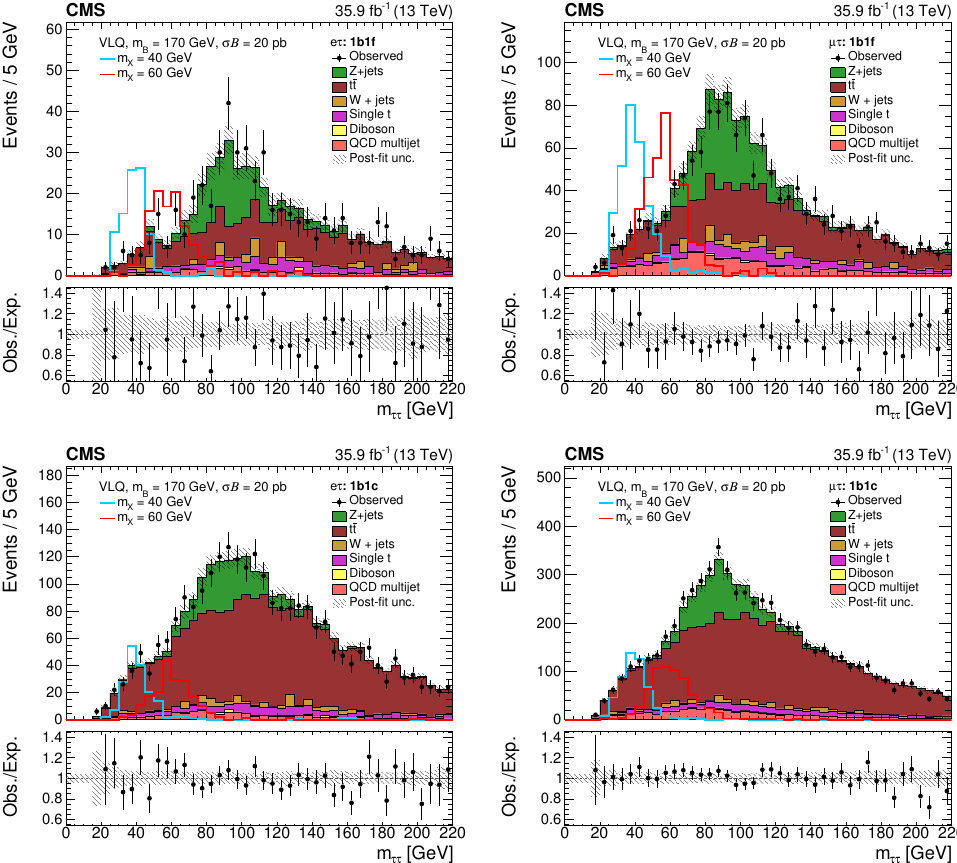
Figure 3 . Measured m distribution in the e t (left), and mt (right) (cid:12)nal states, for the 1b1f h h tt (upper) and 1b1c (lower) categories, compared to the expected SM background contributions. The signal distributions for the VLQ model with X boson masses of 40 and 60 GeV are overlaid to illustrate the sensitivity. They are normalized to the cross section times branching fraction of 20 pb. The uncertainty bands represent the sum in quadrature of statistical and systematic uncertainties obtained from the (cid:12)t. The lower panels show the ratio between the observed and expected events in each